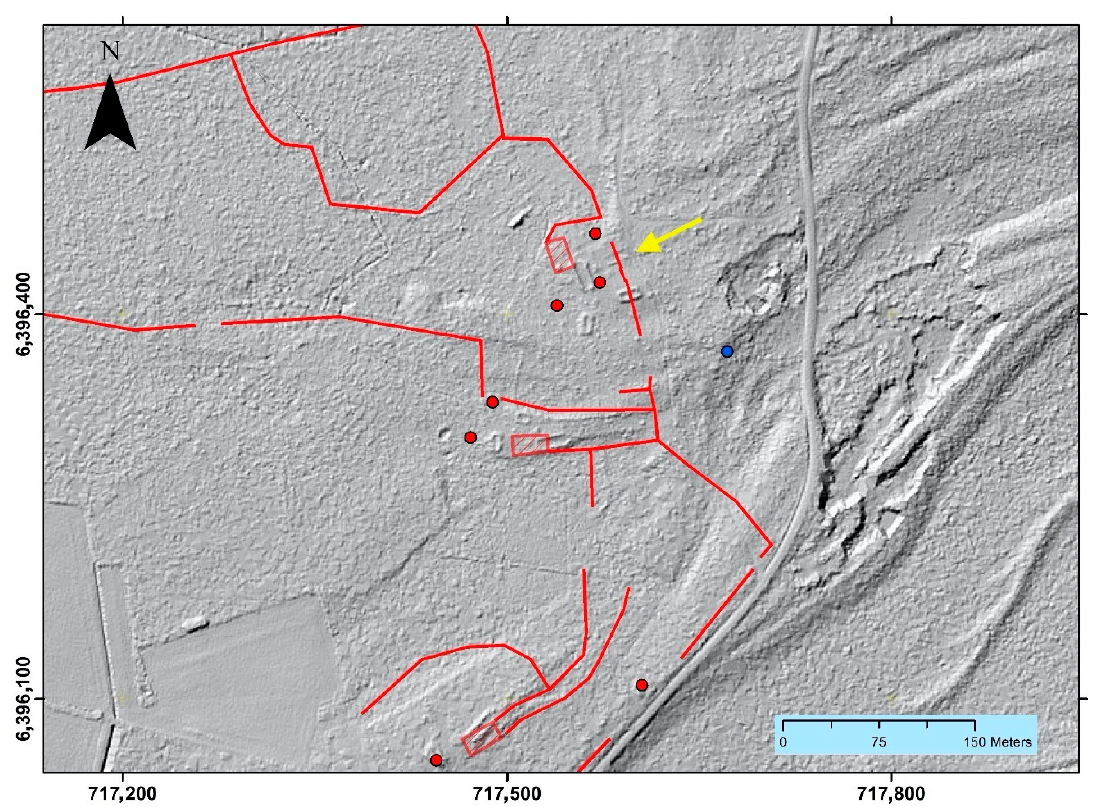
Figure 5. Aränget (Bäl parish, Gotland). Iron-Age house foundations and stone fences enclosing farmland. Orange rectangles and red dots show the geographical location on maps in the national sites and monuments record. It is obvious that they all have a slight offset to the west-northwest compared to their more precise location on the ALS-generated (digital elevation model (DEM). The yellow arrow marks the location of the house foundation in Figure 6. The image illustrates the importance of ALS data for spatial site correction. Coordinates: SWEREF99 TM (Illustration: Daniel Langhammer). © Lantmäteriet Geodatasamverkan.